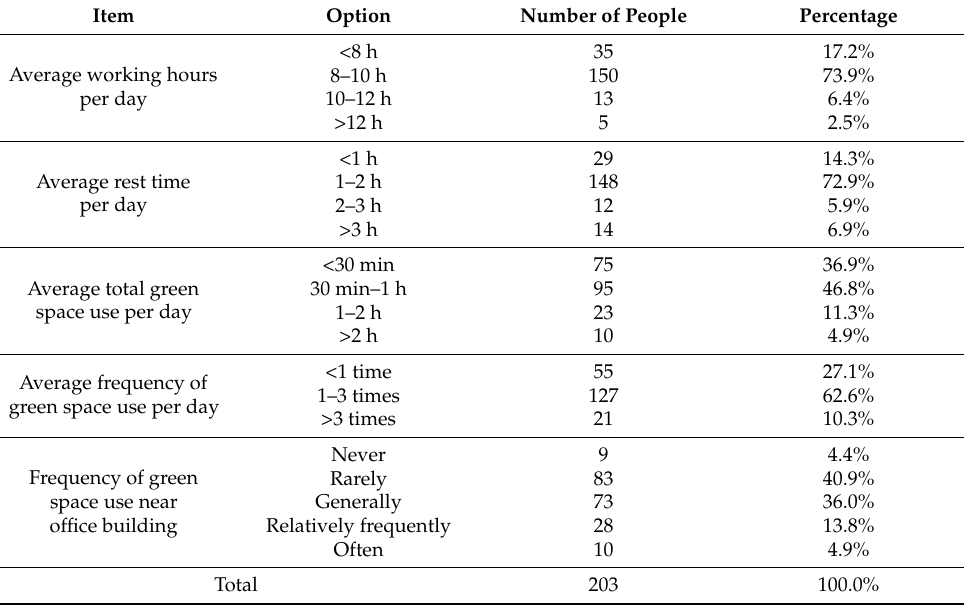
Table 3. Statistics of participants’ working and leisure time and green space use on